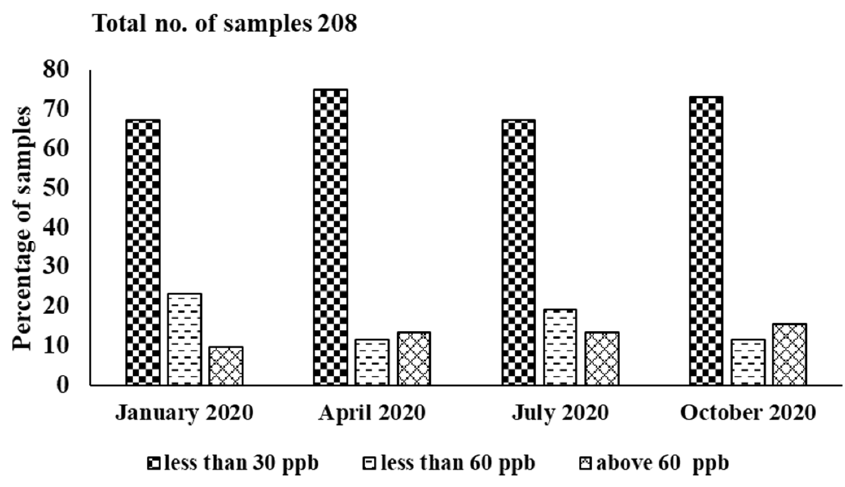
Figure 5. Range of uranium concentration in groundwater.